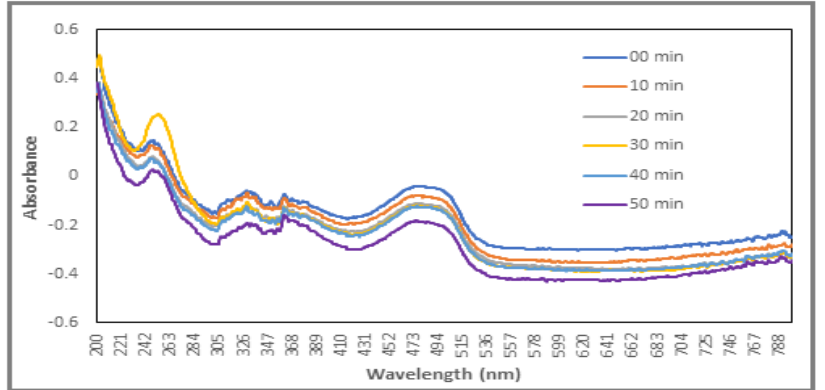
Fig. 6. Graphs showing the dye degradation without FeCr